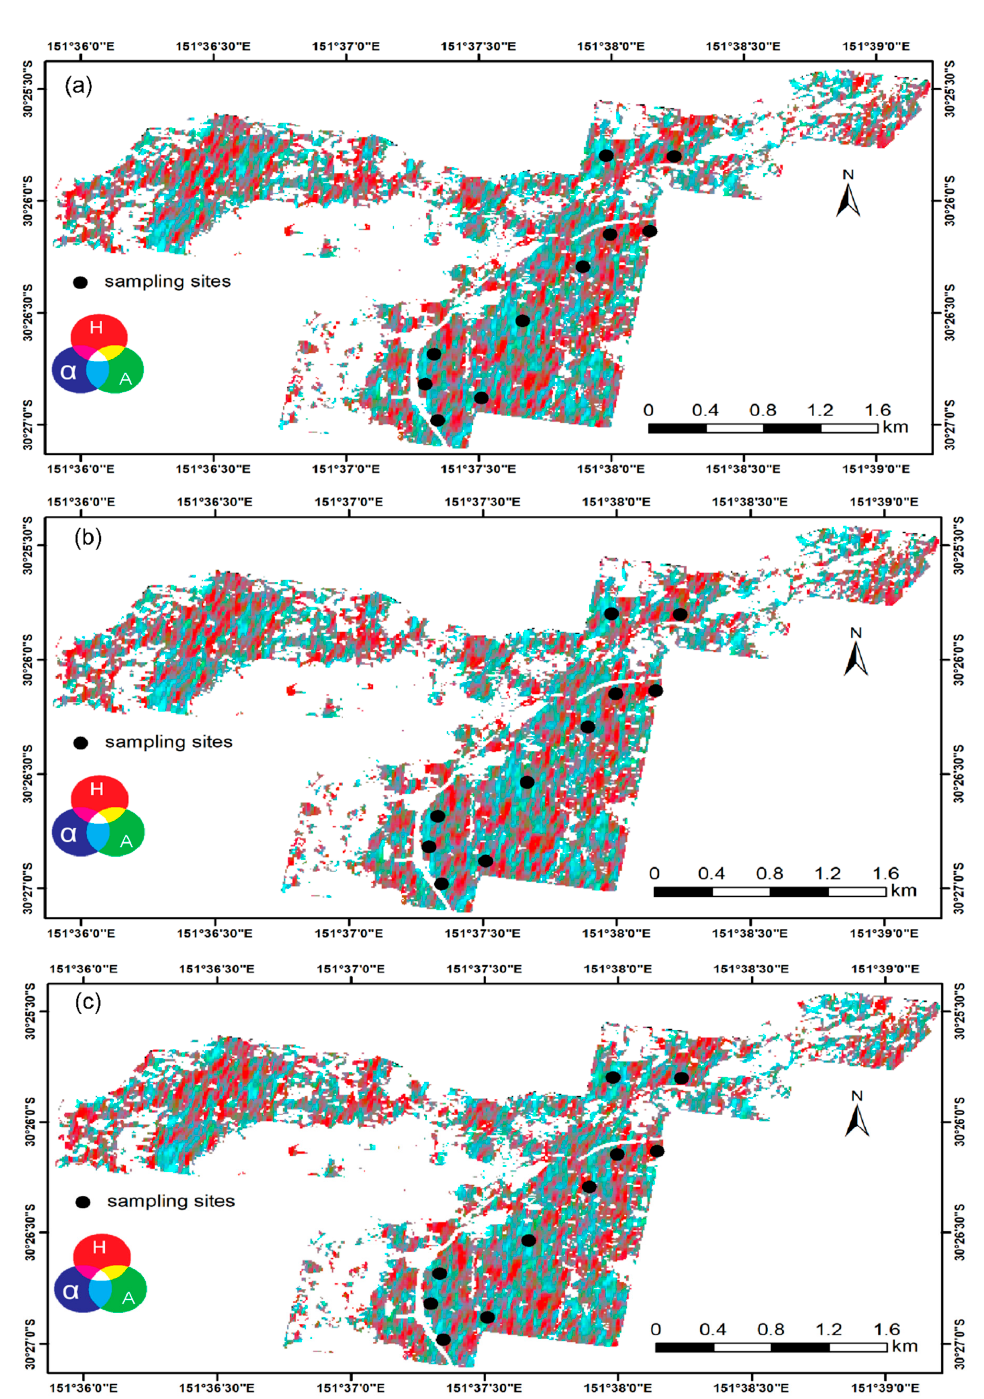
Figure 6. True colour composite images for polarimetric decomposition parameters. The images represent scattering entropy (H), scattering anisotropy (A) and mean scattering angle ( α ) processed with digital elevation model (DEM) of varied spatial resolutions; ( a ) 90 m, ( b ) 30 m and ( c ) 1 m. The red colour in the image denotes the scattering entropy, green colour denotes the scattering anisotropy while blue colour represents the mean scattering angle. Areas with non-herbaceous land cover types have been masked from the image (pixels in white colour represent masked land cover types or image